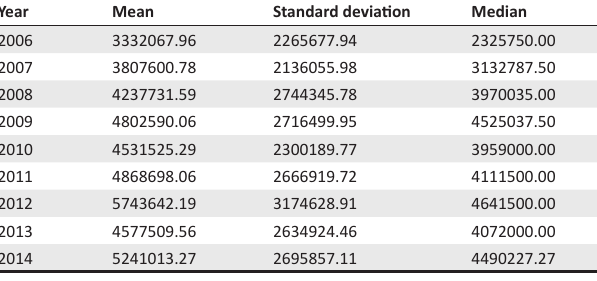
FIGURE 1: Graphical presentation of the descriptive statistics for chief executive officer fixed pay (2006–2014). TABLE 4: Chief executive officer total remuneration summary (R’000).